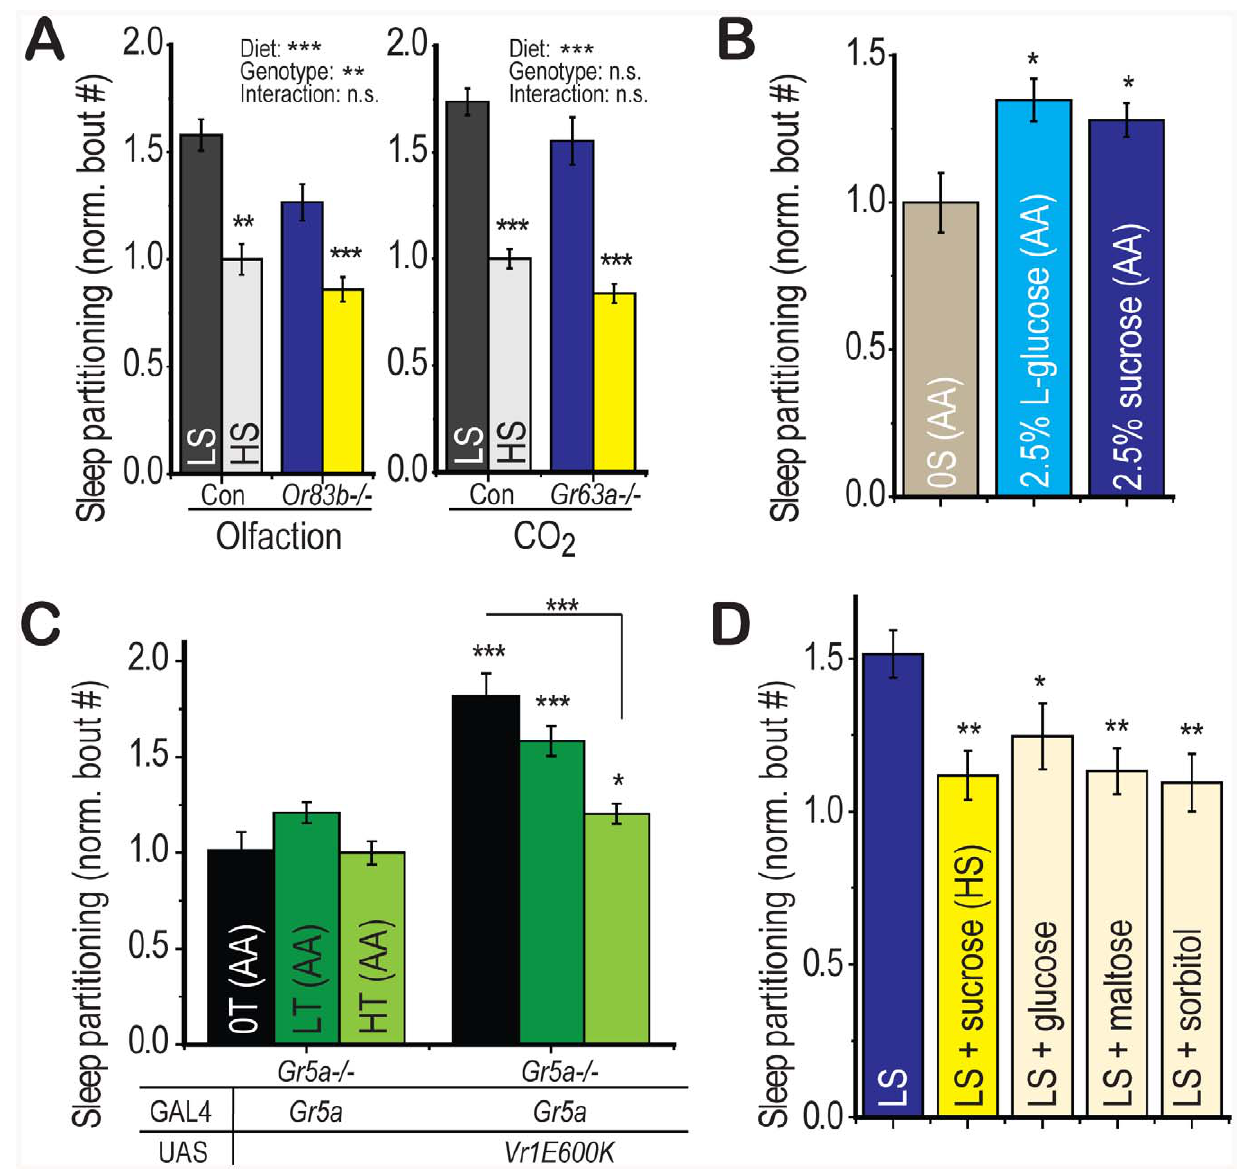
Figure 6. Appetitive gustatory stimulation is necessary and sufficient for diet-induced sleep partitioning. (A) Deletion of either the Or83b olfactory co-receptor or the Gr63a CO 2 sensor is insufficient to suppress the sleep response to dietary sugar relative to genotype-matched controls (no significant diet:genotype interaction by two-way ANOVA). (B) Activation of gustatory perception using the non-nutritional L-isomer of glucose (2.5%) in a sugar-free amino acid base food (AA + L-glucose) was sufficient to induce significant sleep partitioning relative to the amino acid base food without added sugar (0S(AA)). 2.5% sucrose in the amino acid base food (AA + sucrose) was used as a positive control. (C) Sleep partitioning was activated by ectopic expression of Vr1E600K in Gr5a -expressing neurons of the trehalose receptor-deficient Gr5a 2 / 2 mutant. Addition of dietary trehalose to a sugar-free amino acid base food (0S(AA)=0% trehalose, LT(AA)=2.5% trehalose, HT(AA)=30% trehalose) was sufficient to suppress sleep partitioning in the absence of gustatory trehalose perception. (D) Addition of the non-sweet nutritional sugar alcohol sorbitol to LS food (30% total sugar) was sufficient to suppress sleep partitioning with a comparable magnitude to supplementation with the positive control sugars sucrose, glucose, and maltose. Error bars represent mean + / 2 SEM for each group. ***=p , 0.001, **=p , 0.01,*=p , 0.05 for all statistical calculations. Significance values for t-tests between dietary conditions are shown above each set of bars and significance values for two-way ANOVA are shown above the graph, where applicable. Signficance values for panels A and D are from one-way ANOVA with Fisher LSD. See also Figure S5 for additional supporting evidence and a proposed model.